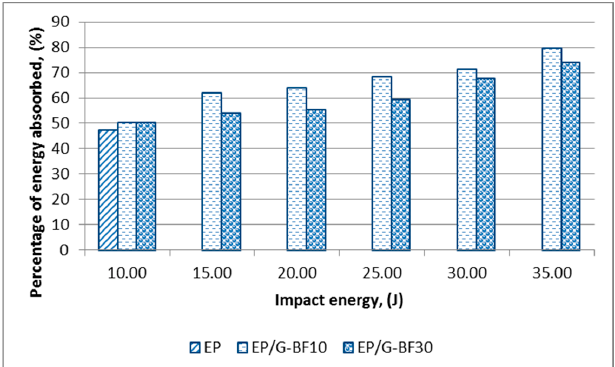
Figure 6. Percentage of energy absorbed by the EP and EP / G-BF composites at the second range of impact energy levels.